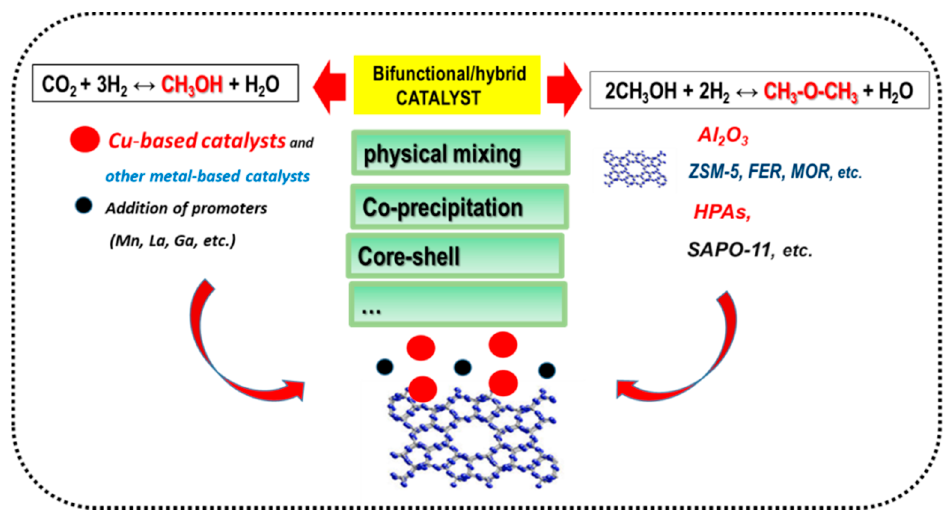
Figure 12. General scheme of the preparation of bifunctional/hybrid catalysts for direct CO 2 hydrogenation to DME.